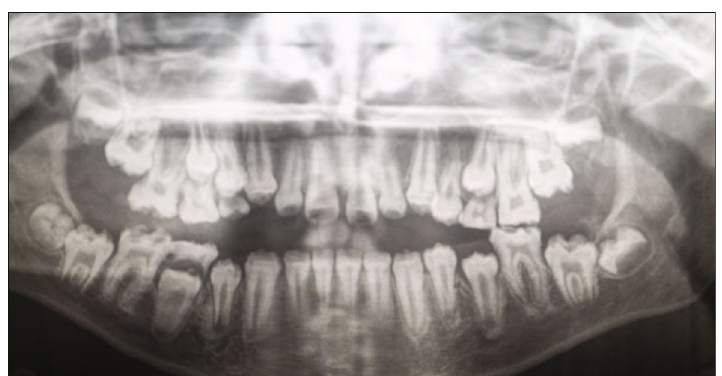
Figure 4: Dental panoramic tomogram